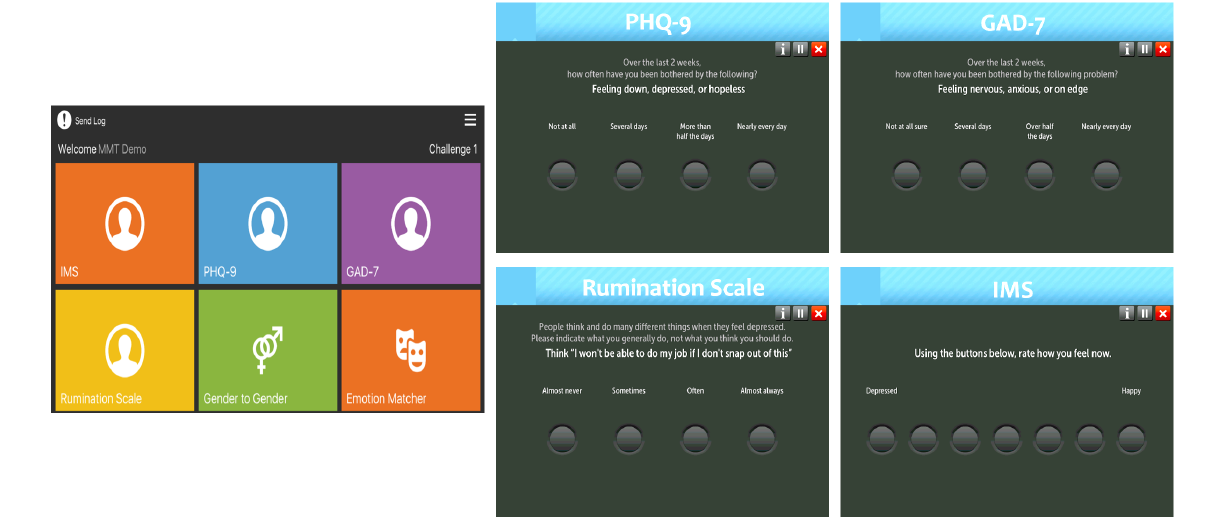
Figure 1. Posit Science’s mobile mood tracker app. Left: the app’s intro screen on the iPad. The user clicks on any tile to start the assessment. Right: single example items from PHQ-9, GAD-7, Rumination, and IMS are shown. PHQ-9: patient health questionnaire, 9-item. GAD-7: generalized anxiety disorder, 7-item. IMS: Immediate Mood